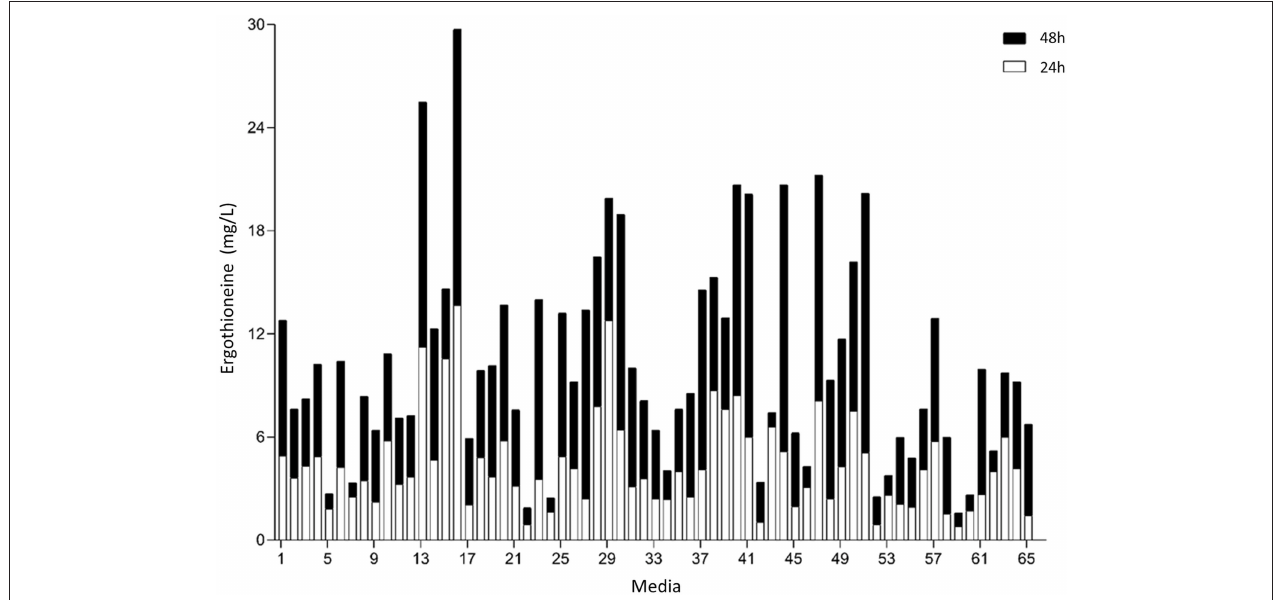
FIGURE 6 | Median concentration of ergothionine produced after 24 and 48h. The values are additive. Open bars represent values obtained after 24h while the closed bars represent values obtained after 48h.